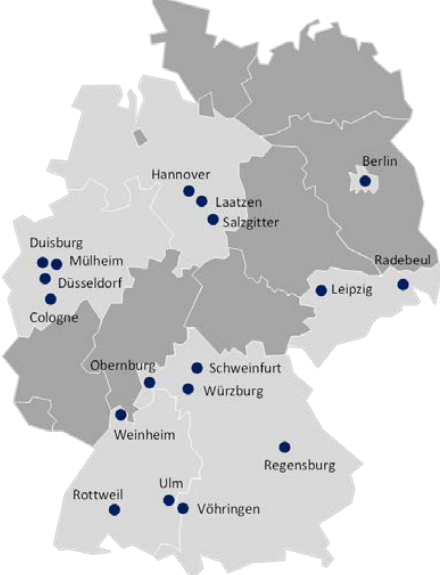
Figure 1. Locations of the participating businesses in 22 cities across Germany.